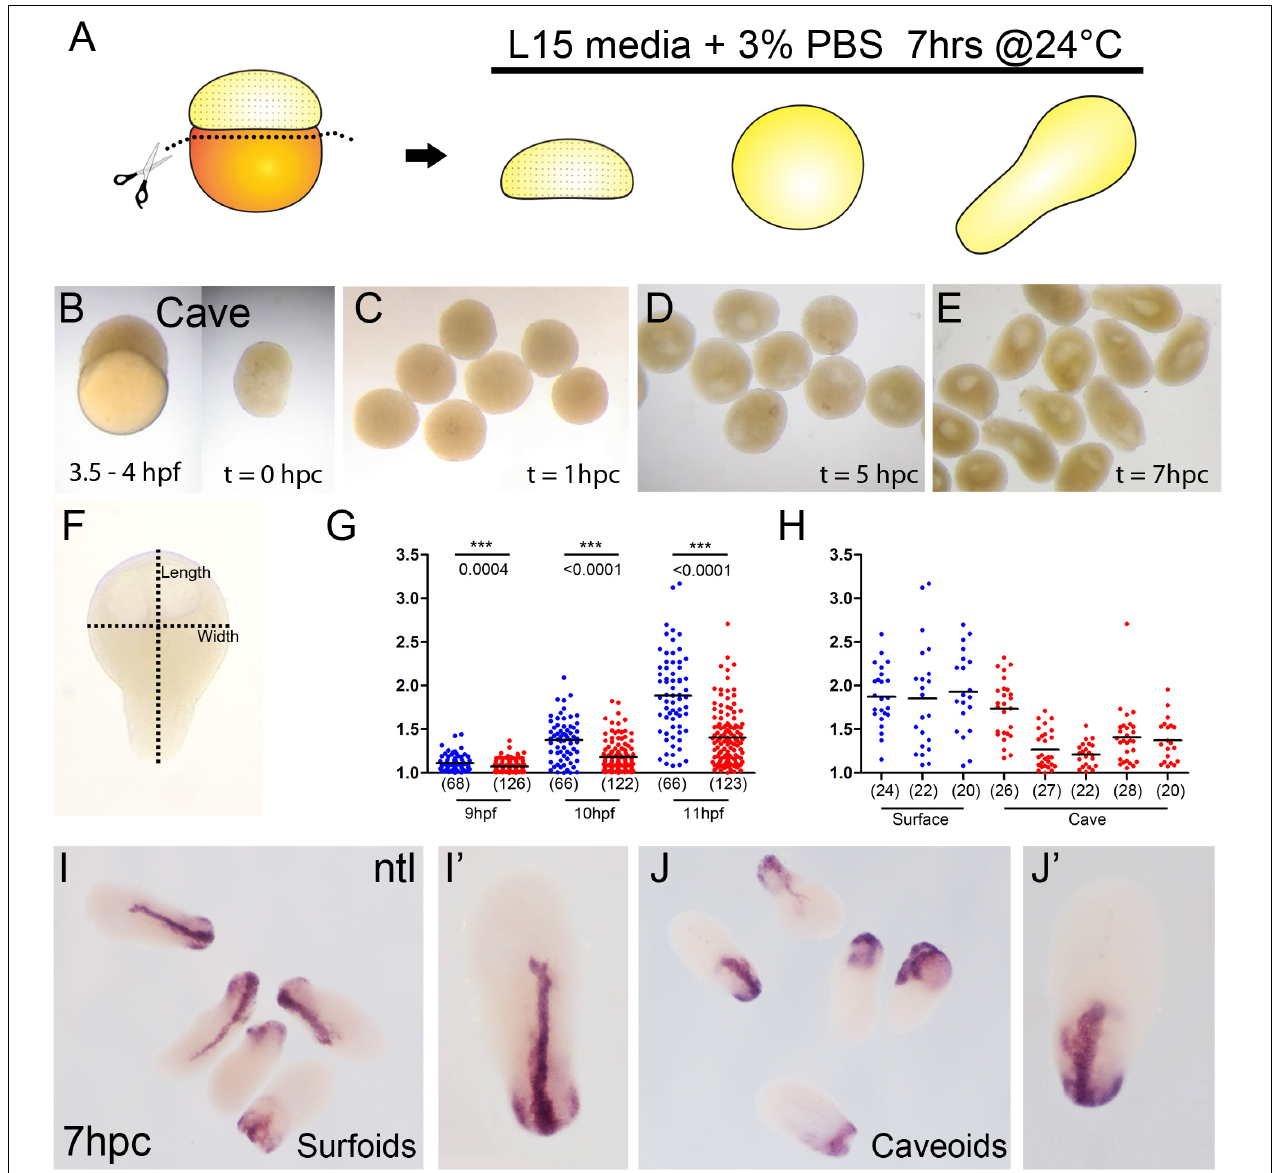
FIGURE 1 | Generation of pescoids in A. mexicanus . Procedure for the generation of Astyanax pescoids (A) . Intact cavefish embryo at 1K-cell stage [ (B), left ] and after yolk removal [ (B), right ]. Development of caveoids after 1, 5, and 7 hpc [ (C–E) , respectively]. Measurement of the length and width on a pescoid to calculate the aspect ratio value as length/width (F) . Measurement of aspect ratio of surface (blue) and cave (red) pescoids at 9, 10, and 11 hpf (G) . Statistical differences (***) between the two morphs are indicated with the corresponding p values obtained by Mann-Whitney tests at every time point and the numbers in parentheses indicate the number of pescoids analyzed (G) . Aspect ratio measurement at 11 hpf in pescoids derived from individual females shows variability in cavefish (3 different females for surfoids, 5 different females for caveoids) (H) . Black lines indicate the mean value (G,H) . Expression of ntl in surfoids (I,I (cid:48) ) and caveoids (J,J (cid:48) ) after 7